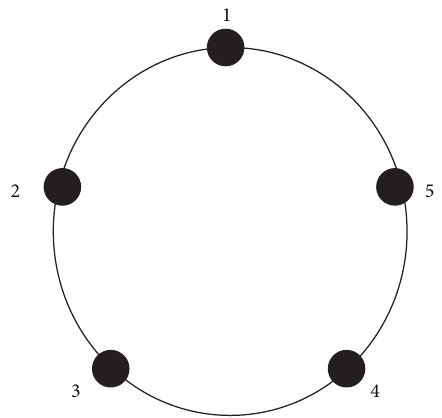
Figure 1: Communication topology among